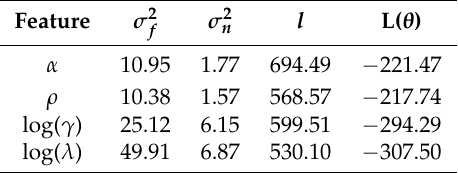
Table 3. Optimal hyperparameters of seismic waveform characteristics.